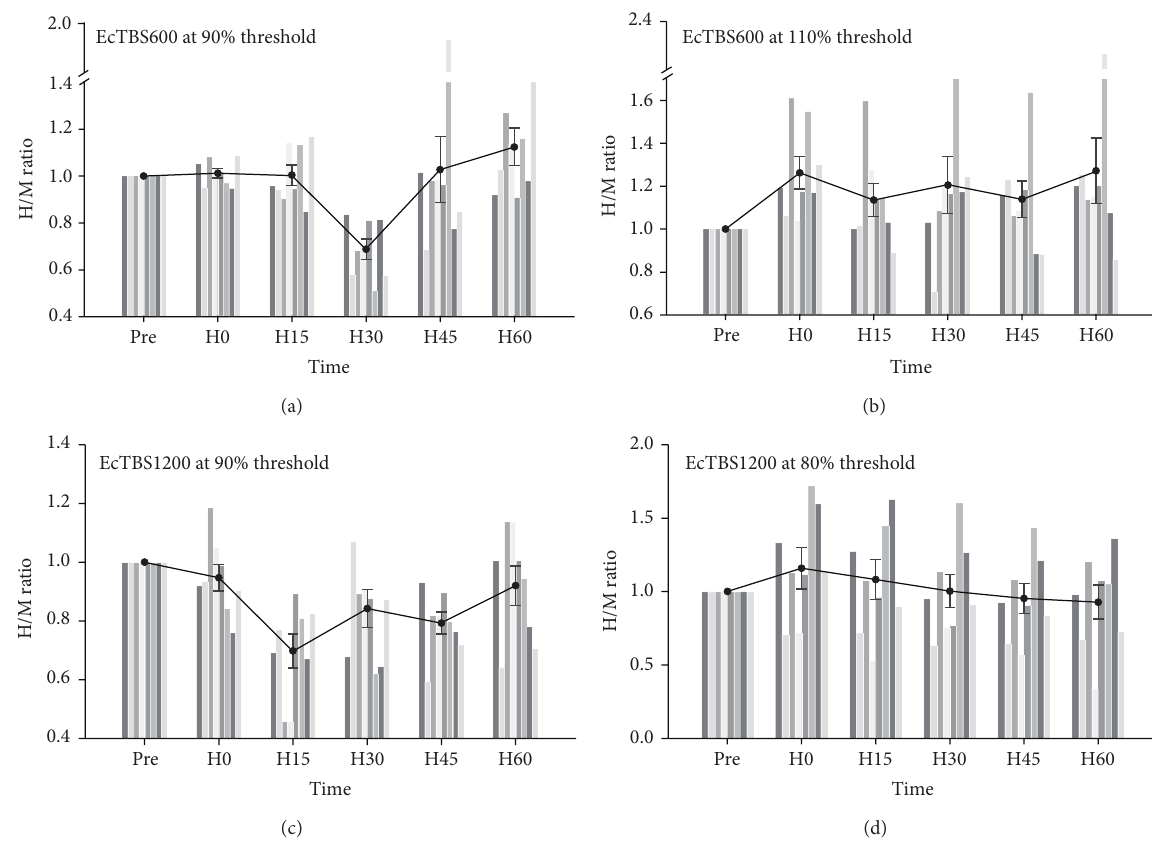
Figure 1: Different patterns of EcTBS lead to different effects on the H-reflex. Inhibition occurred, mainly at 30 min, after EcTBS600 at 90% threshold (a), while mild facilitation occurred after EcTBS600 at 110% threshold (b). In EcTBS1200, stimulation at 90% threshold inhibited the H/M ratio for more than 45 min (c), while EcTBS1200 at 80% threshold produced no after effect (d). The vertical bars are results of each